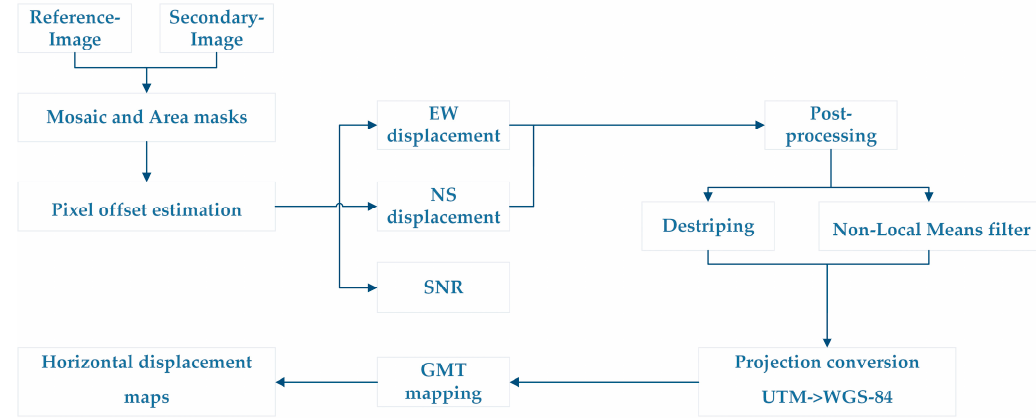
Figure 4. Flow chart of processing of lake ice displacement deformation obtained from Sentinel 2 optical images.